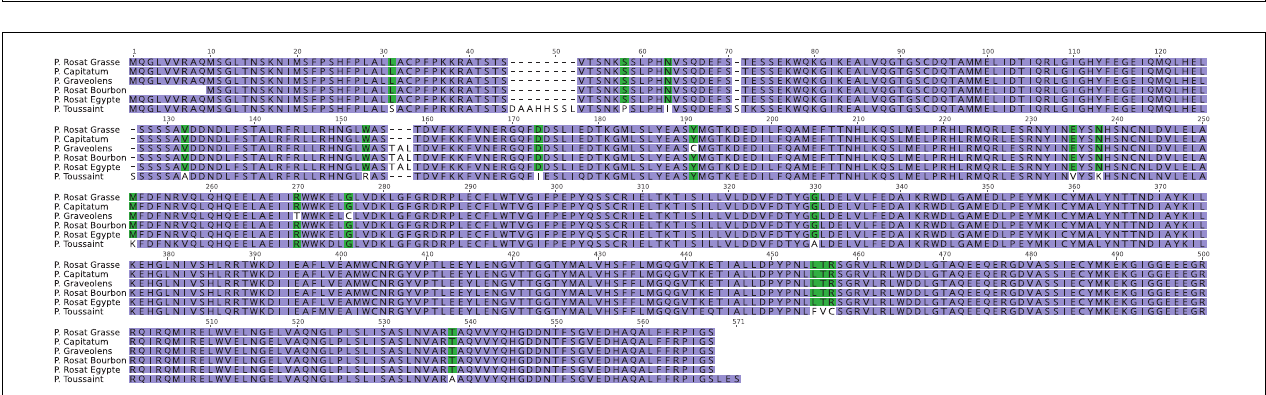
FIGURE 4 | Protein sequence alignment of GESs from different pelargonium rosat cultivars, P. cv. ‘Toussaint’ and two pelargonium rosat parents: P. capitatum and P. graveolens .